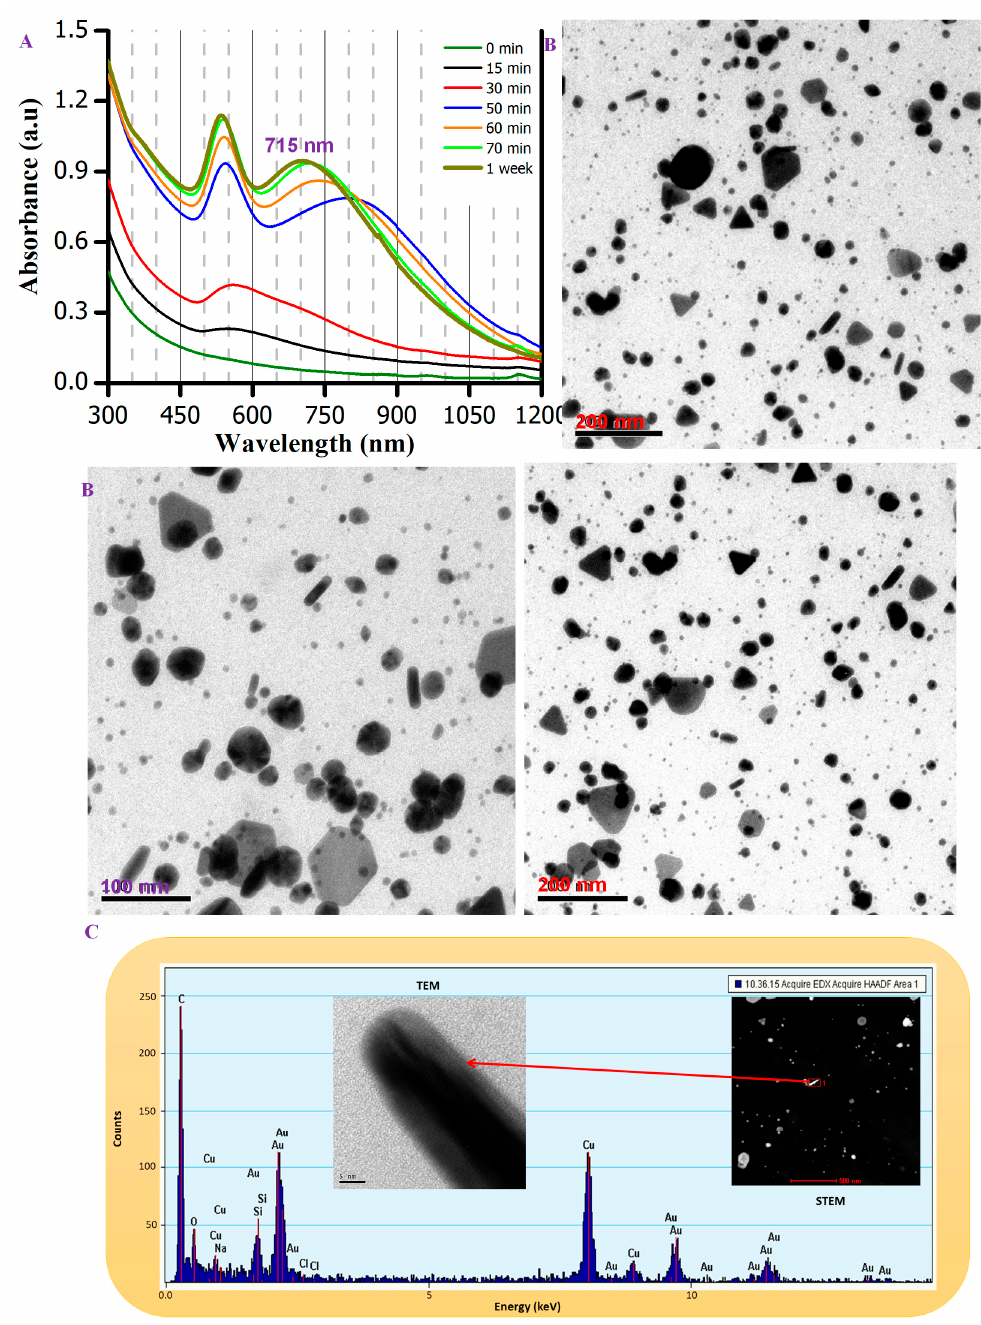
Figure 3. Characterization of NIR-absorbing anisotropic gold nanomosaic (NIRAuNM) formed within 0.5% wt/v of PNIPAm- co -allylamine microgels. In this specific reaction, photolysis was used to reduce 0.023 moles of Au(Me 2 S)Cl in the aqueous microgels medium by a single-step method. ( A ) Time-dependent absorption spectra, ( B ) TEM images, and ( C ) EDS data with TEM and scanning transmission electron microscope (STEM) images. The STEM image in the inset is collected using a high-angle annular dark-filed (HAADF) detector.